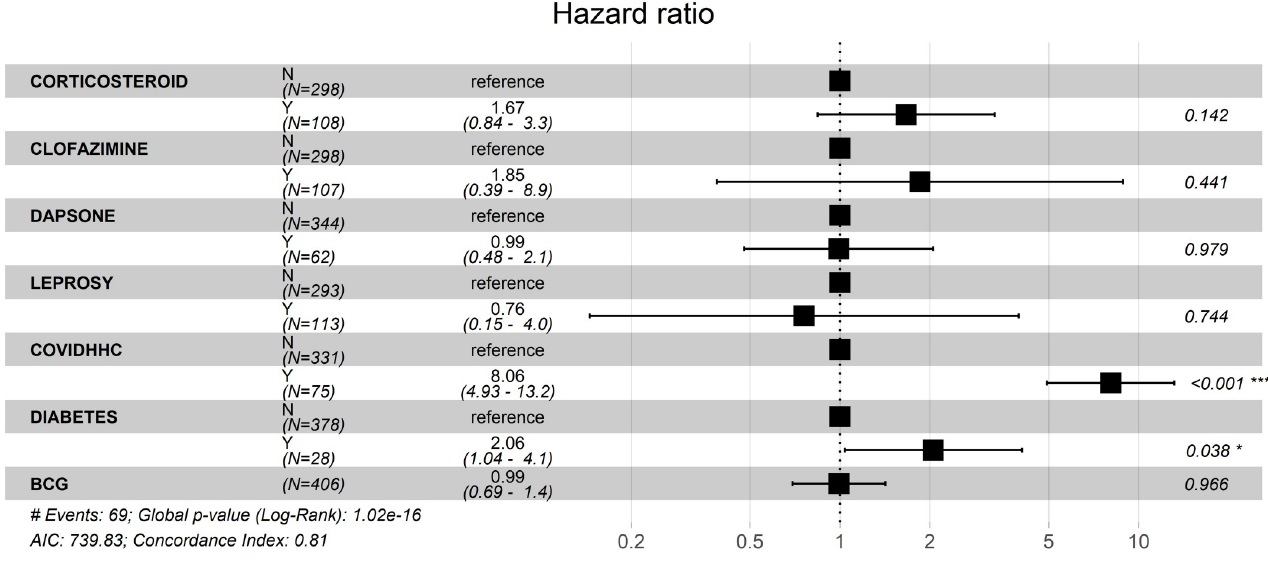
Fig 3. Hazard ratios and 95% confidence intervals calculated by the Cox proportional hazards model.